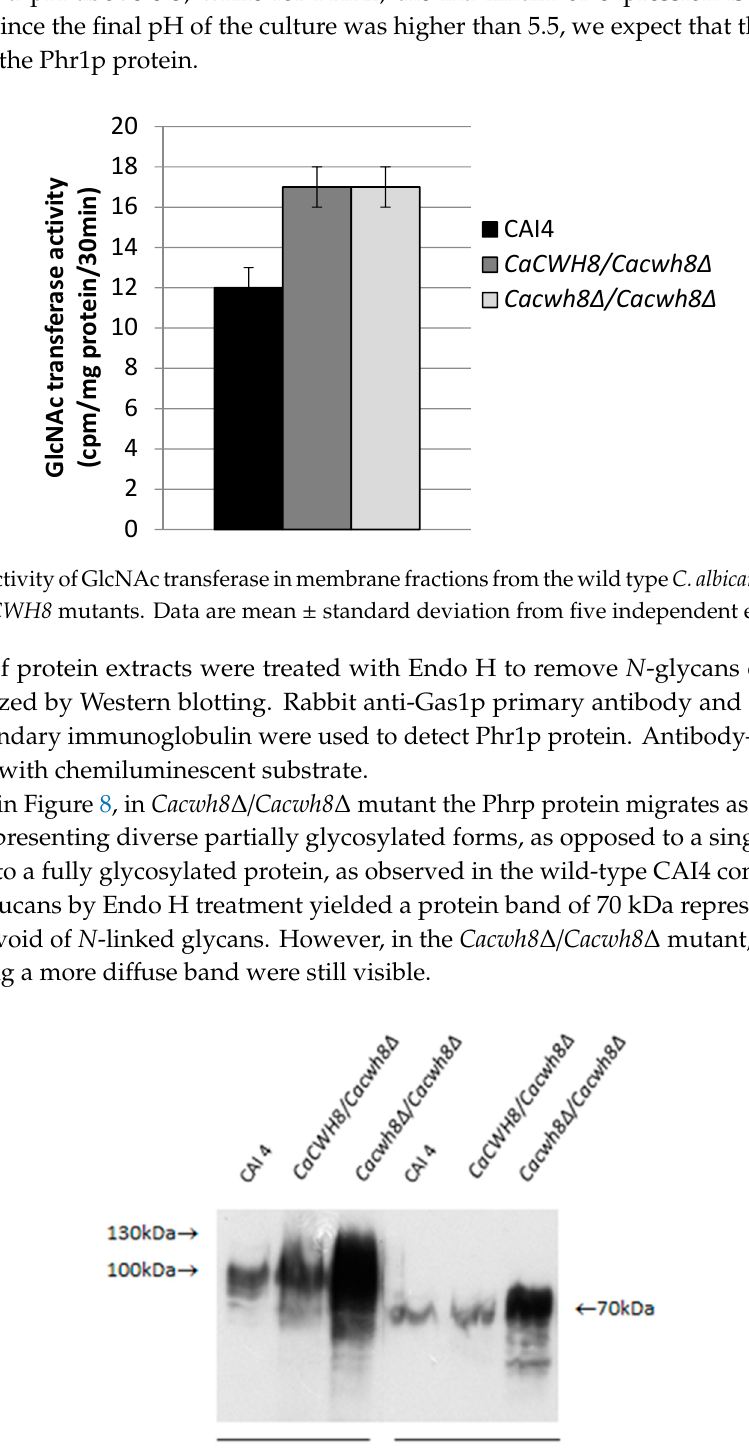
Figure 6. Activity of DPM synthase in membrane fractions from the wild type C. albicans strain CAI4 and the CaCWH8 mutants.